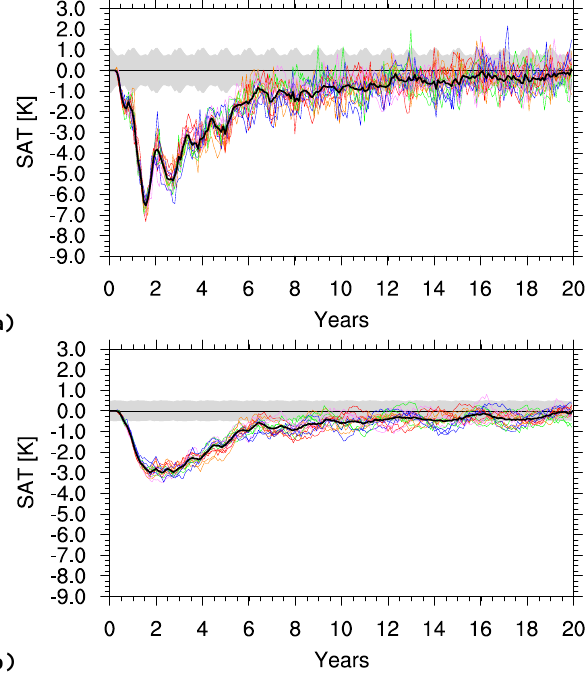
Fig. 2. Time series of global and monthly mean SAT anomalies (K) for (a) the entire 200 years of the model experiments and (b) a close-up of the first 20 years. Colours indicate the ENSO state of the control run at which the individual ensemble members were started: Green for neutral ENSO, dark blue for strong La Ni˜na, pink for moderate La Ni˜na, red for strong El Ni˜no and orange for moderate El Ni˜no. The grey shaded areas indicate the monthly mean 2 σ -bar from the control experiment.